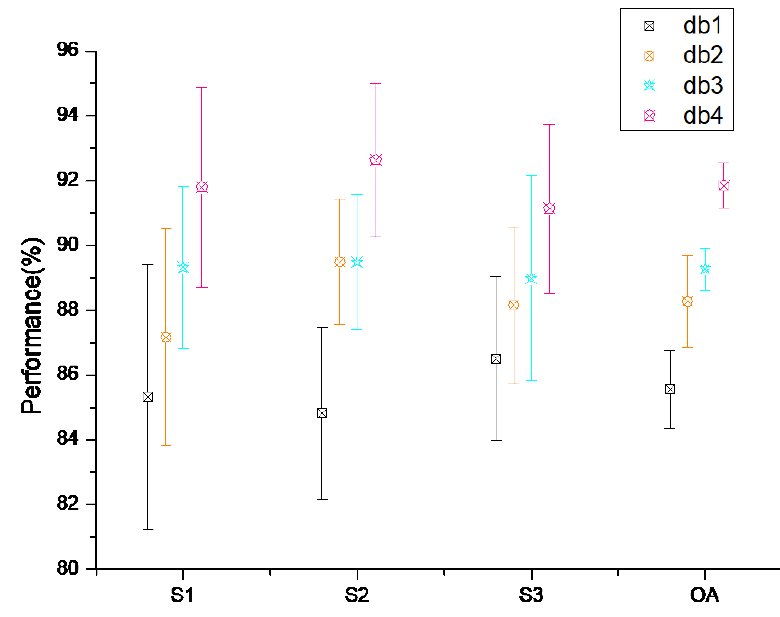
Figure 9. Error bar of different wavelet experiment.